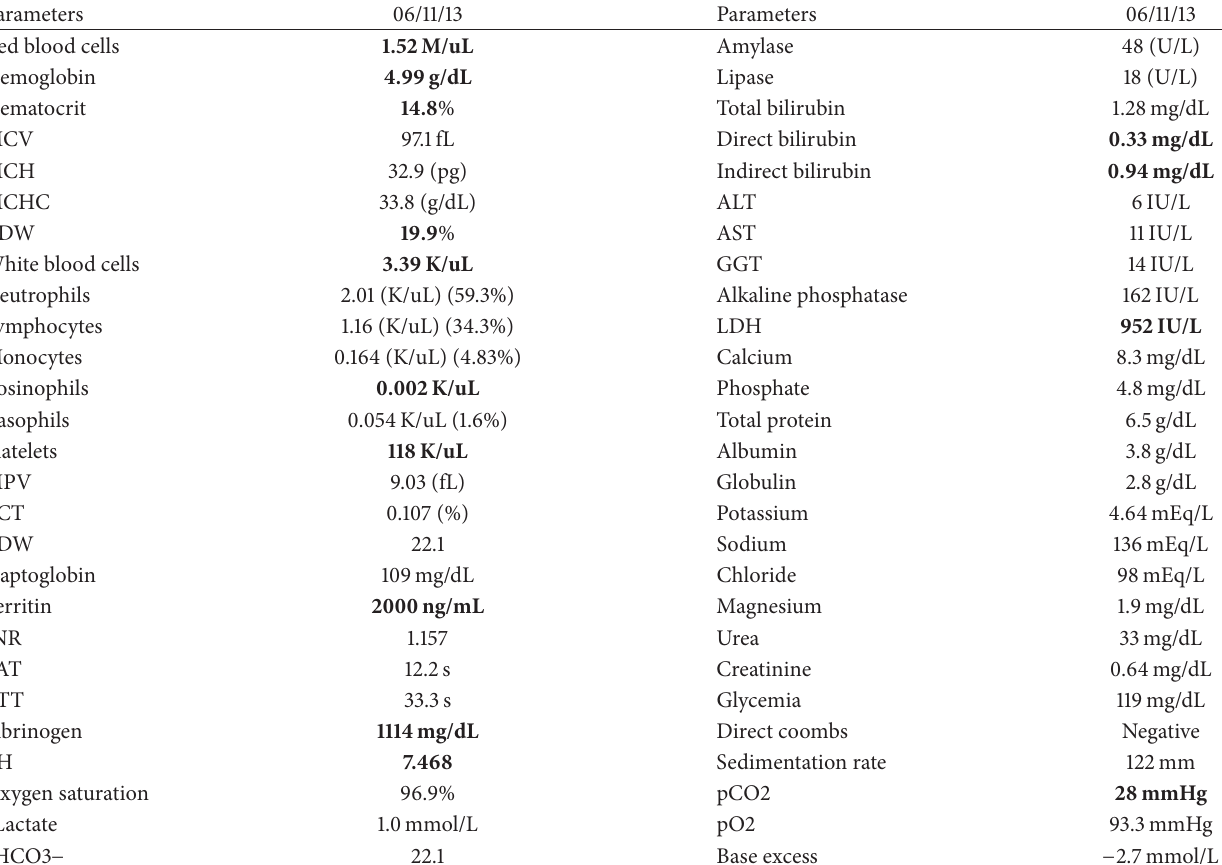
Table 1: Laboratory